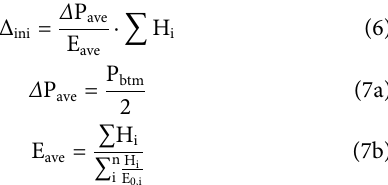
Variation of effective stress at the top of strata